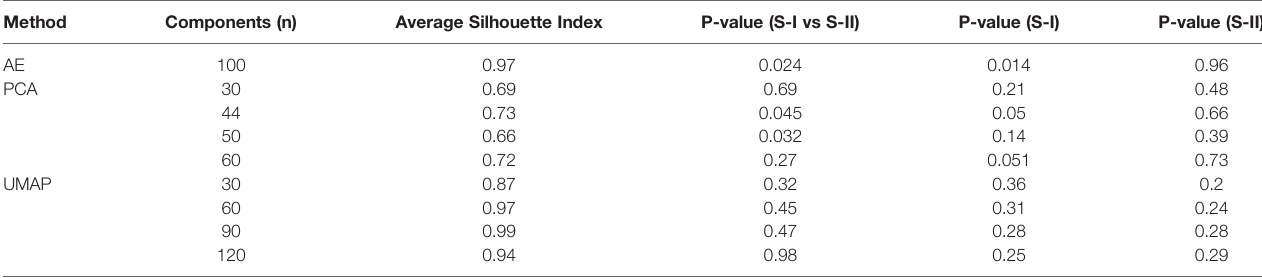
TABLE 2 | Performance of AE and two alternative approaches.